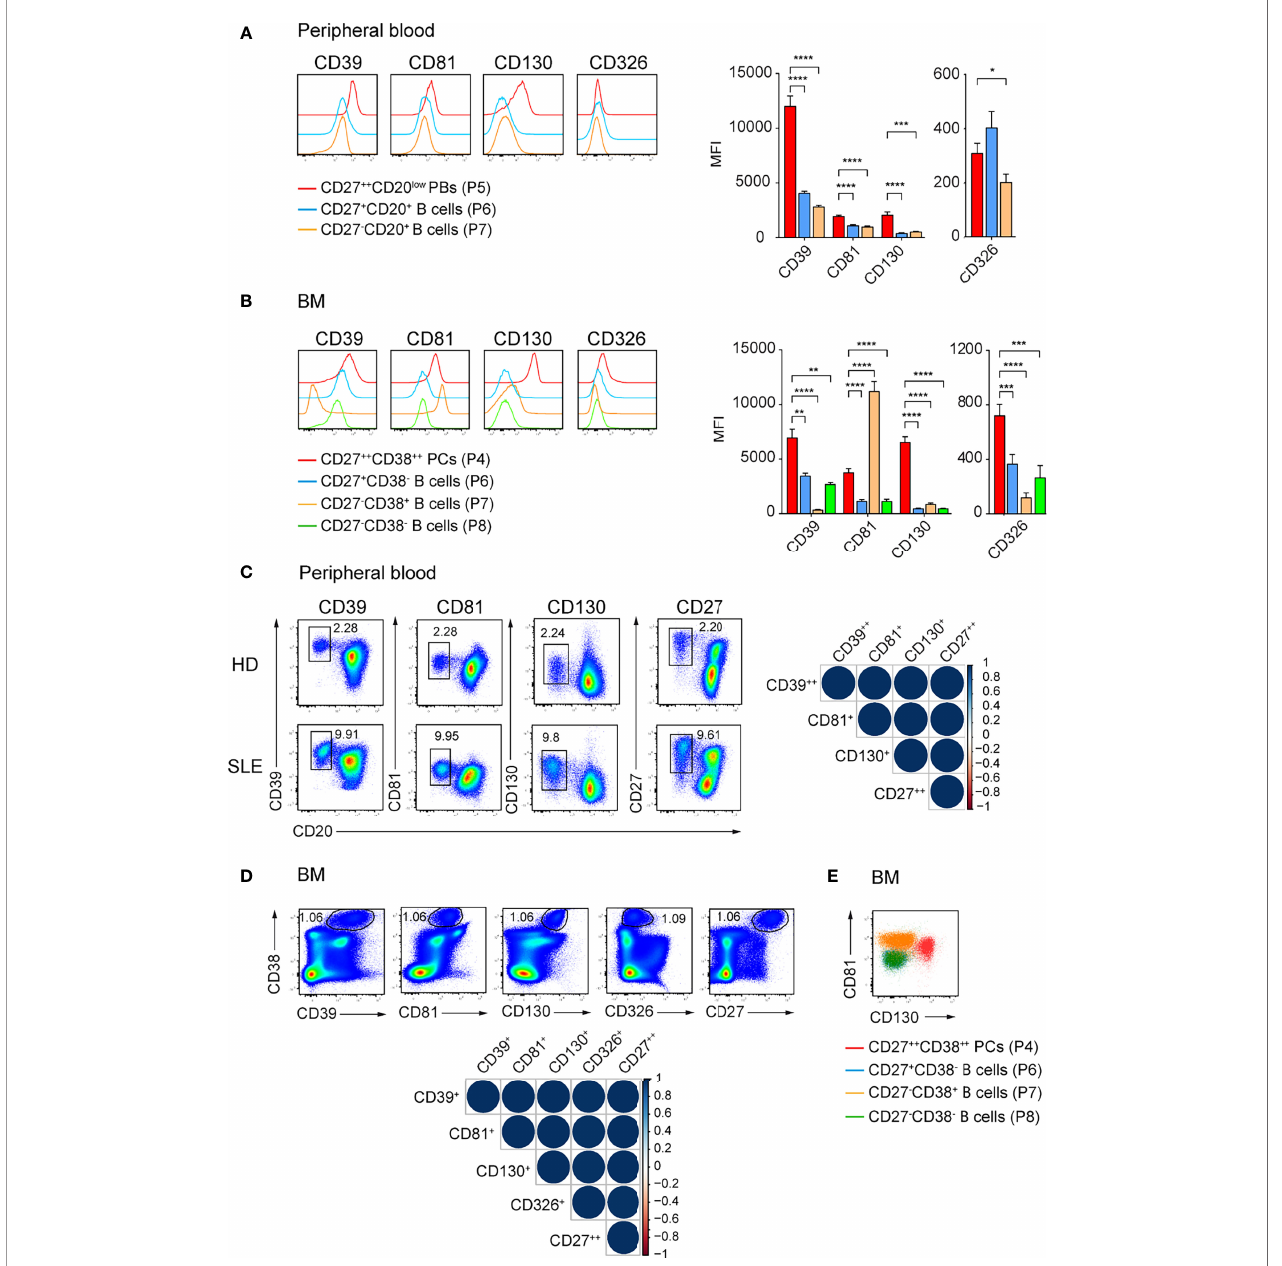
FIGURE 4 | CD39, CD81, and CD130 expression reliably identi fi es human ASCs. (A, B) Representative histograms (left) and graph (right) showing the expression of the indicated surface molecules by ASCs versus other B cell subsets in human peripheral blood (A) and BM (B) . ASCs and B cell subsets from peripheral blood and BM were gated as shown in Supplementary Figure 4A, B , respectively. Groups were compared using two-way ANOVA with the Geisser-Greenhouse correction followed by Dunnett ’ s multiple comparisons test. (C, D) FACS plots showing ASCs identi fi cation by the co-expression of CD39, CD81, CD130 or CD27 and CD20 in peripheral blood (C, left) and by the co-expression of CD39, CD81, CD130, CD326 or CD27 and CD38 in BM (D, top). (C) CD39 ++ CD20 low , CD81 + CD20 low , CD130 + CD20 low , and CD27 ++ CD20 low cells were gated on P4 ( Supplementary Figure 4A ). (D) CD38 + + CD39 + , CD38 ++ CD81 + , CD38 ++ CD130 + , CD38 ++ CD326 + , and CD38 ++ CD27 ++ cells were gated on P3 ( Supplementary Figure 4B ). Spearman correlation matrix showing reliable identi fi cation of ASCs populations in peripheral blood (C, right) and BM (D, bottom). Blue color coding indicates positive correlation with color intensity and the size of circle re fl ecting correlation coef fi cients. (E) Representative FACS plot showing the expression CD81 and CD130 by BM CD27 ++ CD38 ++ PCs (red), CD27 + CD38 - memory B cells (blue), CD27 - CD38 + (orange) and CD27 - CD38 - (green) immature B cells. Data were a compilation of 12 HDs and 6 SLE for peripheral blood, and 9 HDs for BM. Data show mean ± SEM ( ∗ p < 0.05, ∗∗ p < 0.01, ∗∗∗ p < 0.001, ∗∗∗∗ p < 0.0001). P values > 0.05 are not